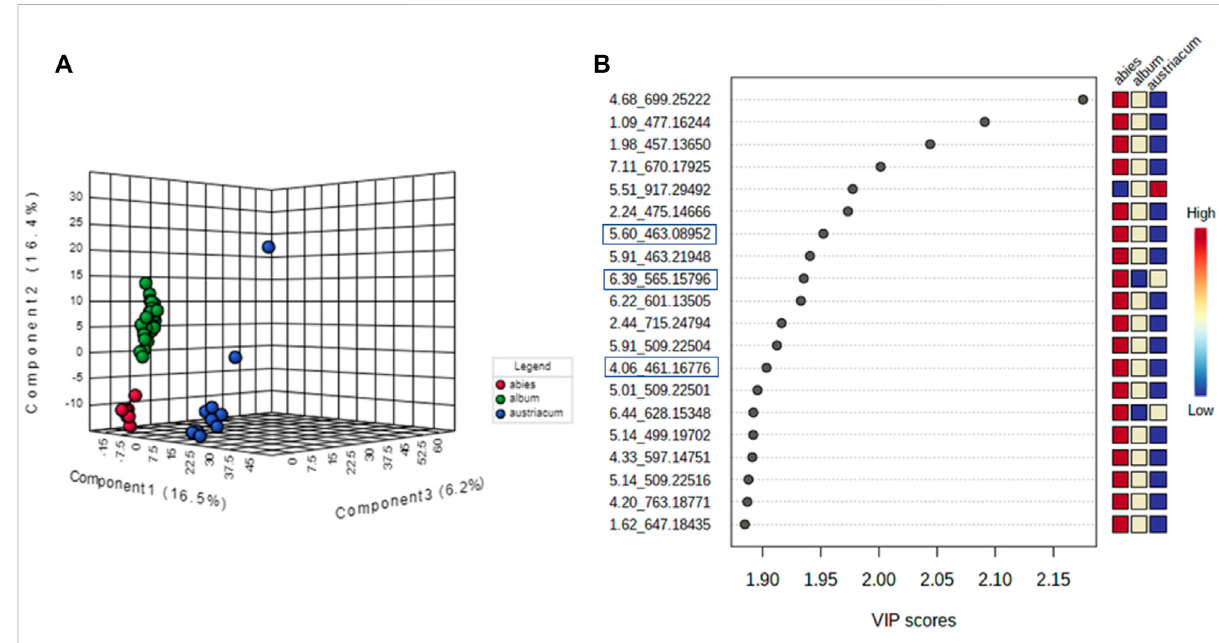
FIGURE 9 PLS-DAof V.album mothertinctures.Discriminationofthesamplesinrelationto V.album subspecies. (A) PLS-DA3Dscoreplotofthenegative ESI mode and. (B) VIP of the negative ESI mode. Blue rectangles: annotated VIP.